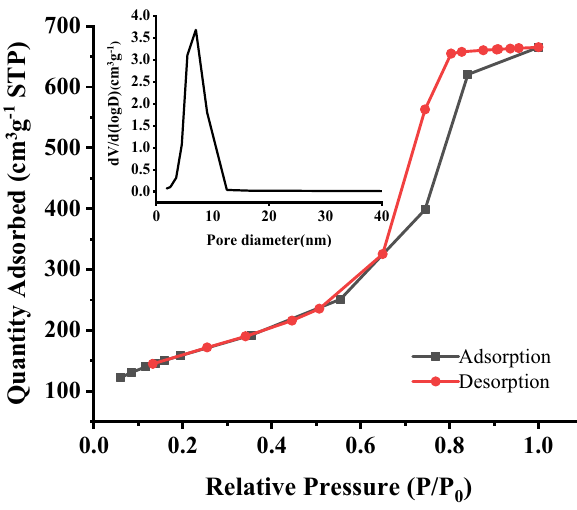
Figure 3: N 2 adsorption – desorption isotherms of TUD - 1. Inset: cor - responding pore - size distribution.